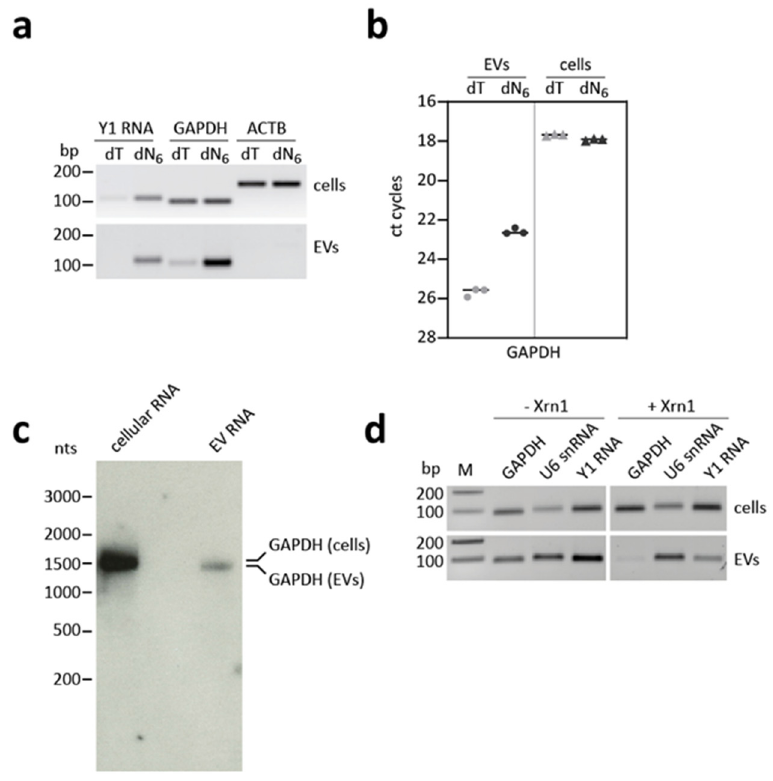
Figure 4. EV-associated and cellular GAPDH mRNA differ in size and polyadenylation status. ( a ) Total RNA from ES-2 cells and their corresponding EVs were isolated, followed by RT-PCR. For reverse transcription, either oligo(dT) or random hexamers (dT, dN 6 ) were used. Markers (200, 100 bp). ( b ) RNA was isolated from ES-2 cells and their corresponding EVs. For reverse transcription, either oligo(dT) or random hexamers (dT, dN 6 ) were used, and GAPDH mRNA was quantified by RT-qPCR. ( c ) Detection of GAPDH mRNA in EVs by the glyoxal northern blot analysis. Total cellular and EV-RNA (300 ng) were analyzed by glyoxal agarose gel electrophoresis and Northern blotting. Exposure time 3 min ( d ) Total RNA from ES-2-derived EVs was isolated and treated with Xrn1 exoribonuclease (+Xrn1). As control, no enzyme was added ( − Xrn1). RT-PCR was performed using primers directed against transcripts indicated. Markers (200, 100 bp).